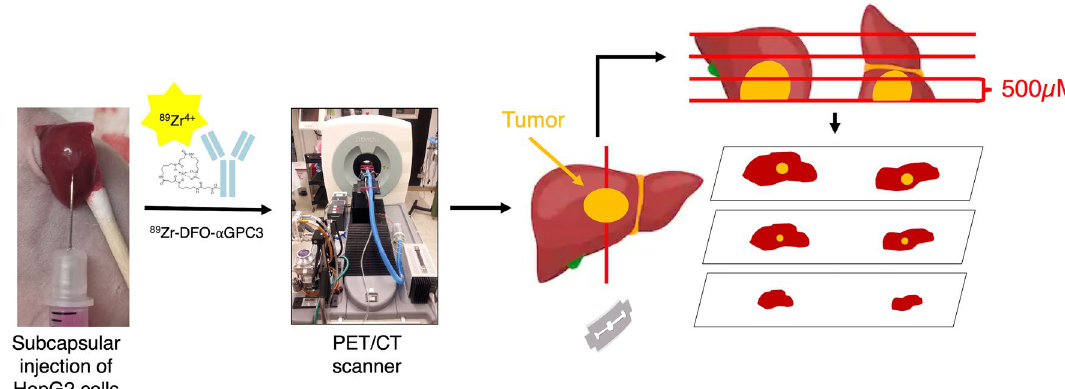
Fig. 2 Experimental schematic. At pre-specified times after subcapsular hepatic injection of human HepG2 cells, 11.1 MBq of 89 Zr-αGPC3 was injected via the tail vein. Four days after injection, whole-body PET and CT images were acquired. Animals were subsequently euthanized, and livers were assessed for tumors histologically